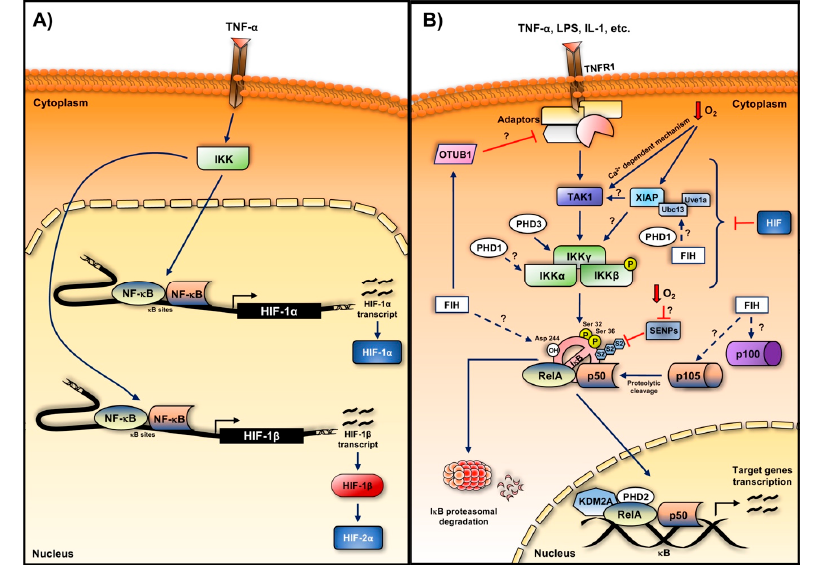
Figure 3. Levels of crosstalk between the HIF and the NF ‐κ B pathways. ( A ) NF ‐ κ B control over the HIF pathway; ( B ) Reported points of interaction and control of the HIF pathway over the NF ‐ κ B signalling cascade. Red T ‐ bars indicate inhibition points, whereas arrows with dashed lines indicate regulation events that have not been proved in an in vivo system yet. Question marks are used to highlight the unanswered questions into the HIF regulation of the NF ‐ κ B pathway.